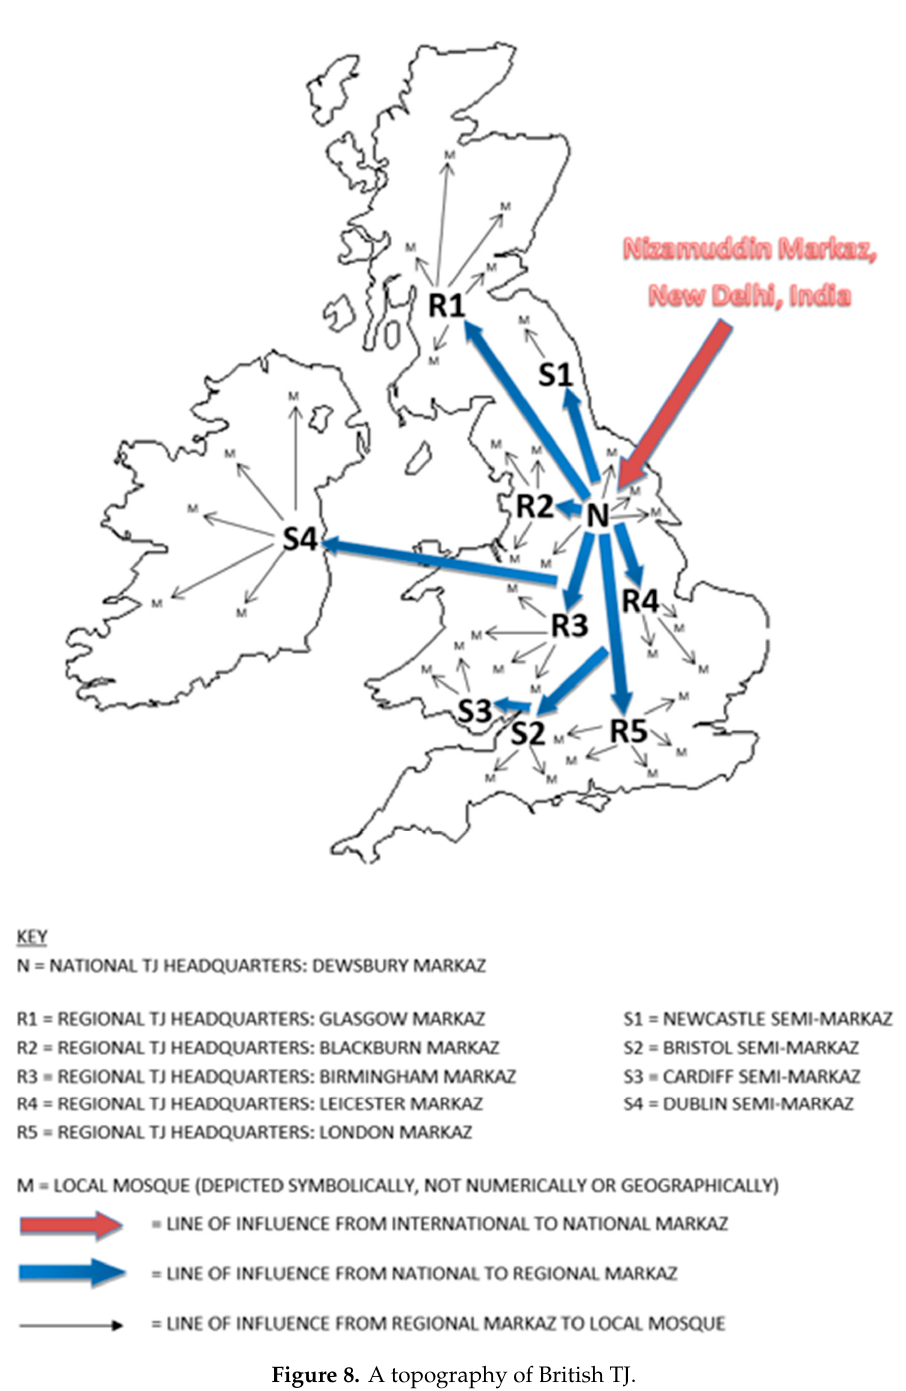
Figure 8. A topography of British TJ.